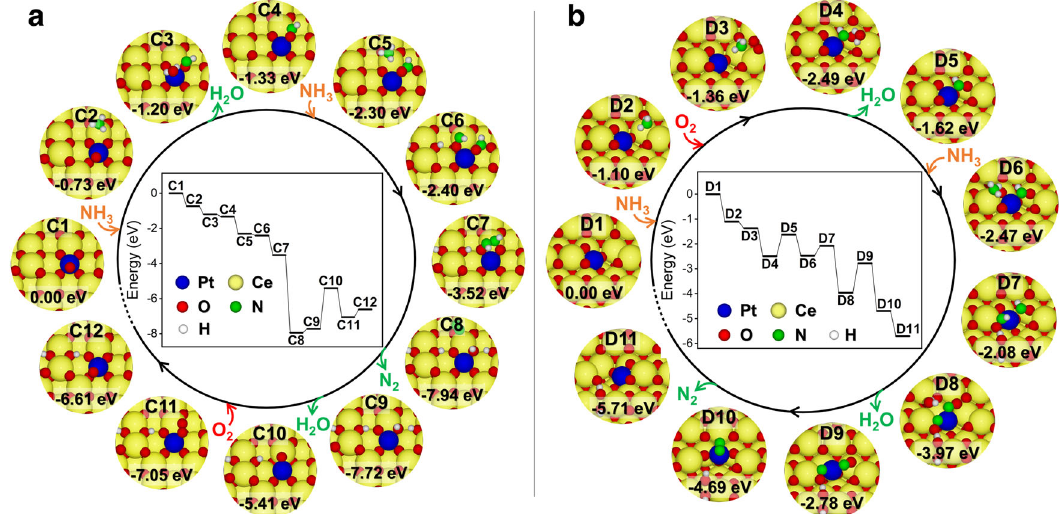
Fig.9|NH 3 oxidationmechanismsondifferentPt 1 /CeO 2 catalysts. ProposedmechanismsofNH 3 oxidationon a Pt@CeEdge-O(representingPt/CeO 2 -550catalyst)and b Pt@CeO v (1) (representing Pt/CeO 2 -800 catalyst). Potential energies were calculated with respect to NH 3 and O 2 in gas